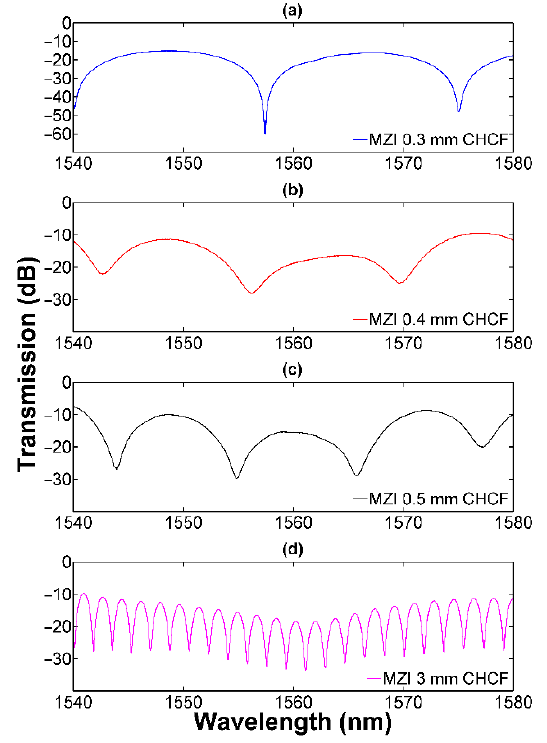
Figure 2. Measured transmission spectra and corresponding FSR of ( a ) MZI 1a (17.82 nm), ( b ) MZI 1b (13.29 nm), ( c ) MZI 1c (10.98 nm), and ( d ) MZI 2 (1.8 nm).